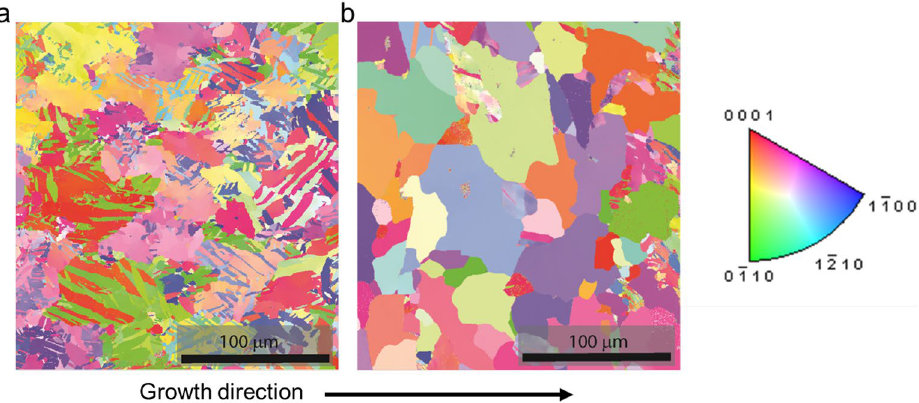
Figure 4. EBSD of 96-h ( a ) DC-plated and ( b ) pulse-plated bismuth coatings.